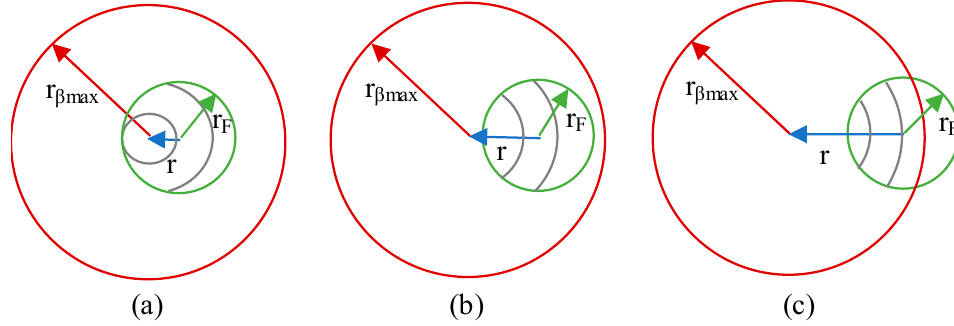
Figure 4. Case II integration sequence as r increases ( a ) circumferences and arcs, ( b ) circumferences and arcs with a different upper u limit, ( c ) only arcs.